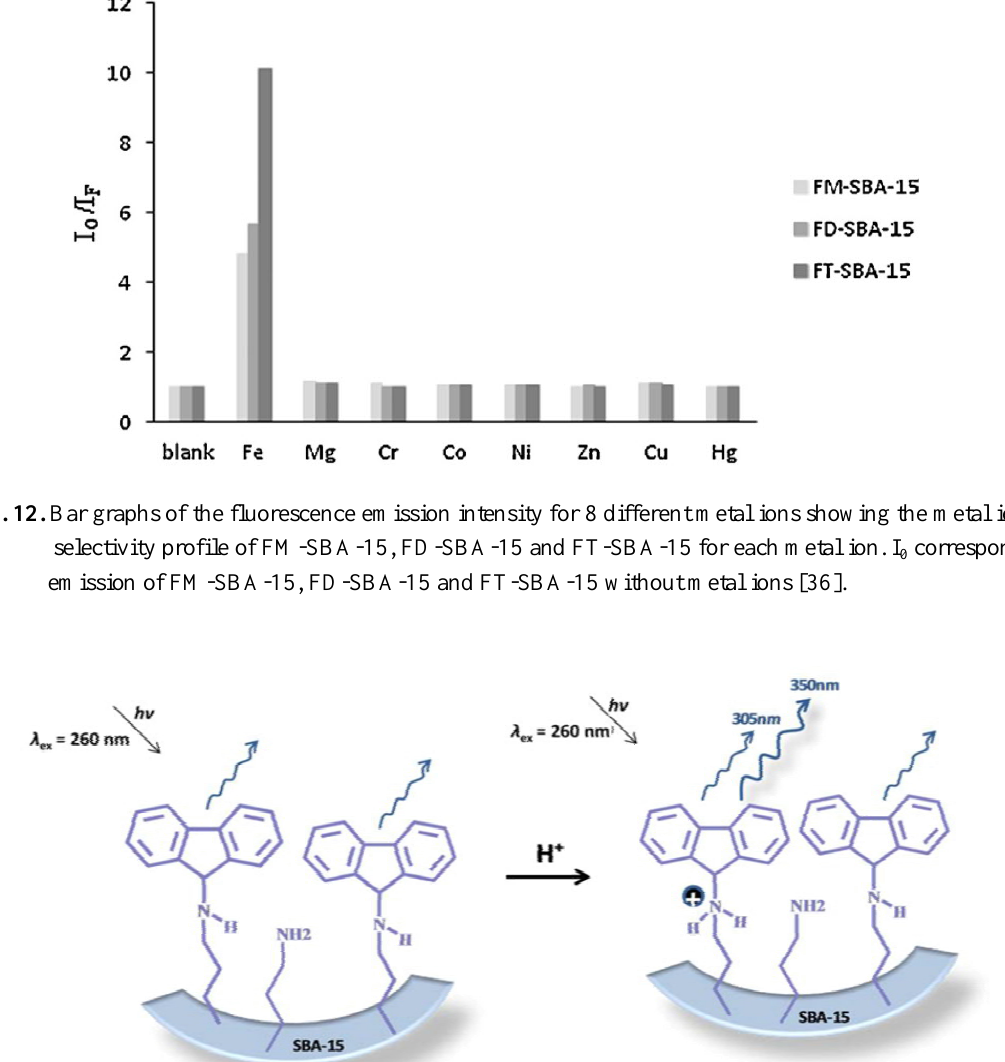
Fig. 13. Fluorescence emission of FM-SBA-15 and protonation of amine group